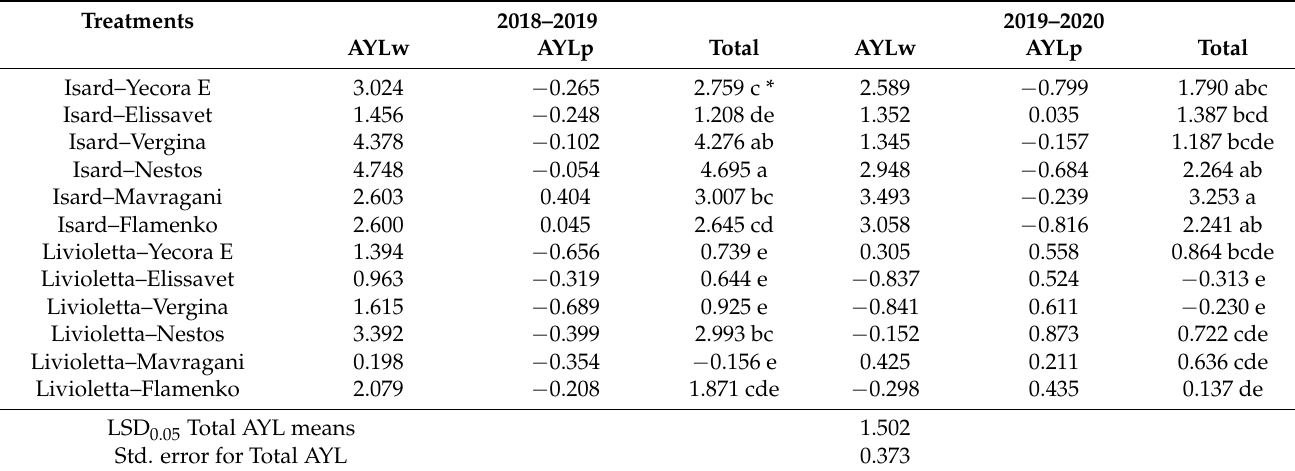
Table 5. Mean actual yield loss of wheat (AYLw), pea (AYLp), and total actual yield loss (AYL) of the different intercropping treatments.